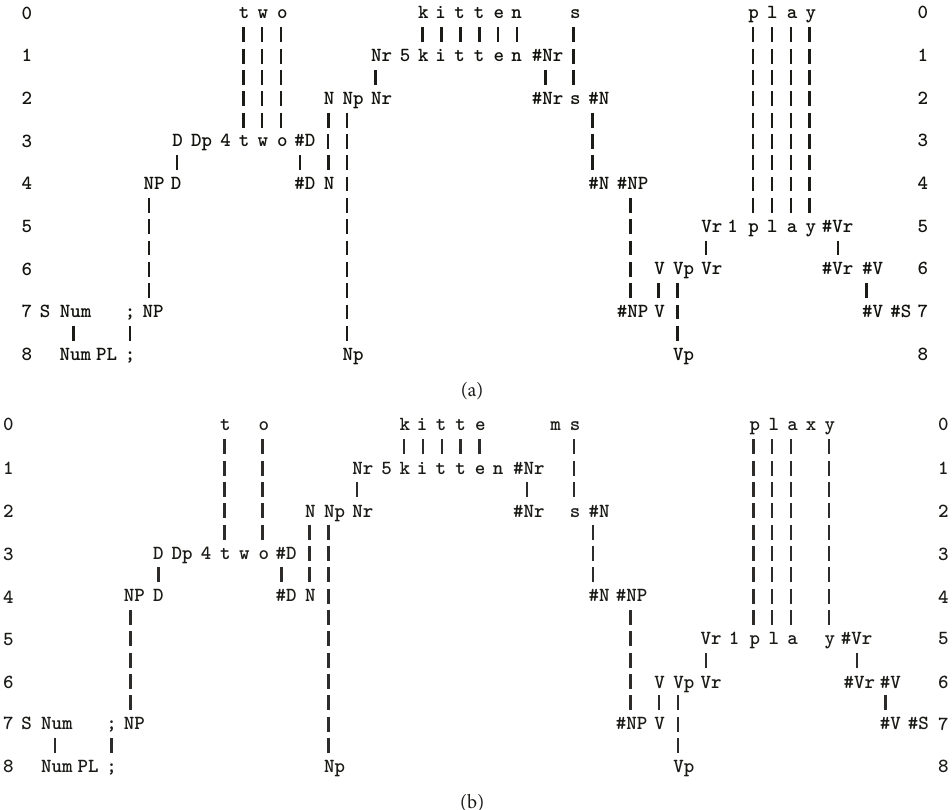
Figure 19: (a) The best SP-multiple-alignment created by the SP model with a store of Old SP-patterns like those in rows 1 to 8, representing grammatical structures, including words, and a New SP-pattern in row 0, representing a sentence to be parsed. (b) As in (a) but with errors of omission, commission, and substitution in the New SP-pattern and with same set of Old SP-patterns as